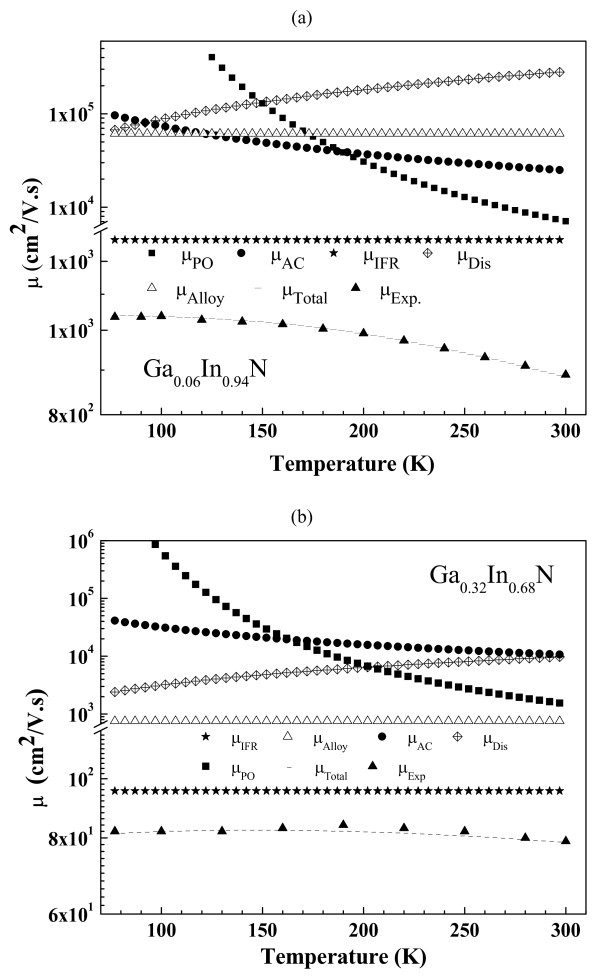
Experimental and calculated temperature dependence of mobility curves for (a) Ga0.06In0.94 N and (b) Ga0.32In0.68 N.